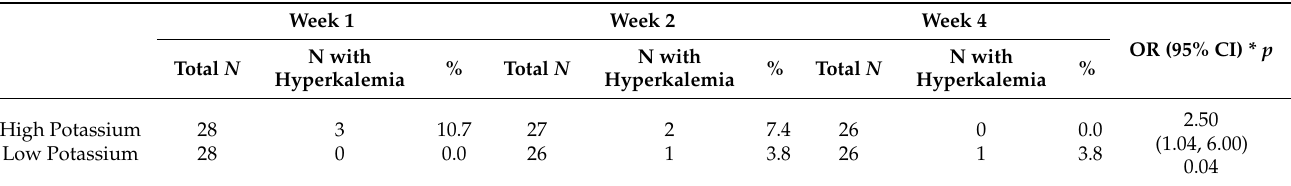
Table 4. Instances of hyperkalemia (K > 5.5 mmol/L) during the trial according to high versus low potassium diet. Week